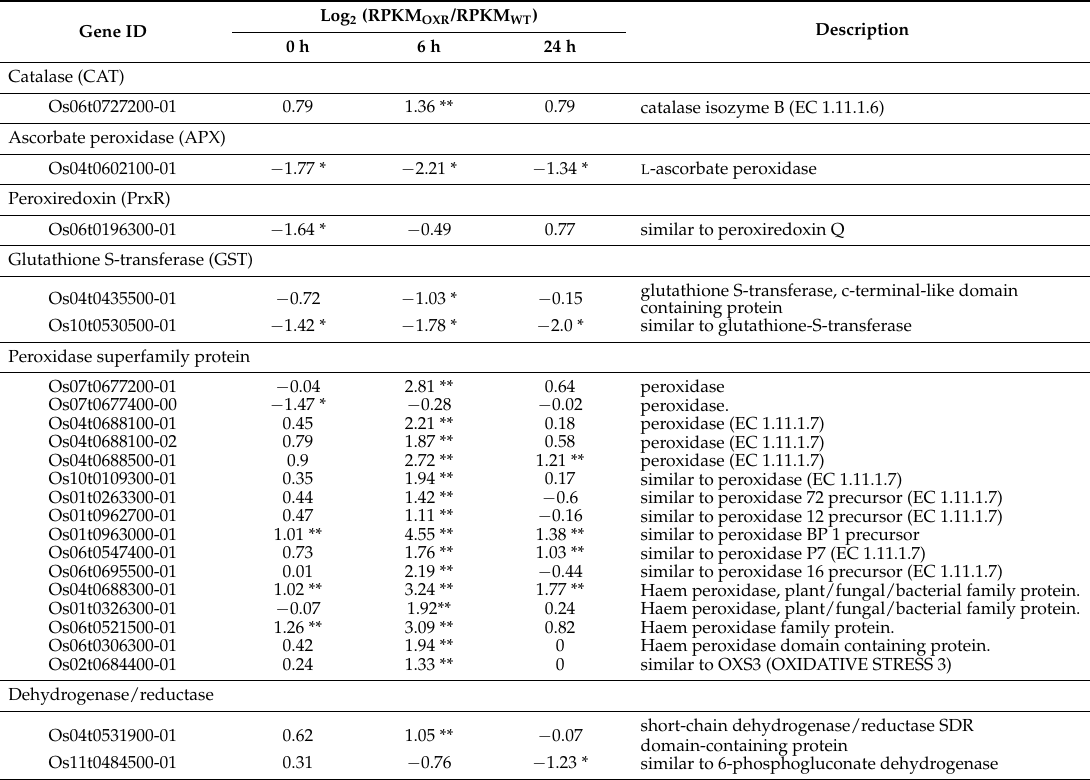
Table 3. List of DEGs related to redox regulation under PEG